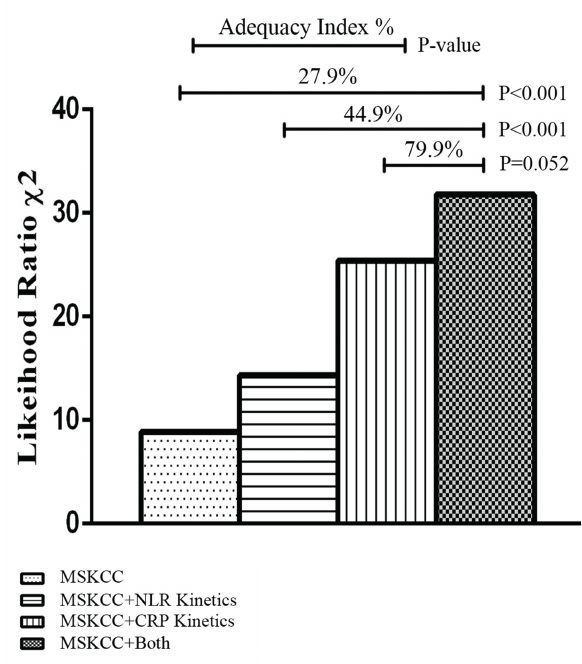
Figure 2 - The likelihood ratio χ ² test showing the adequacy index for different prognostic models. The columns, from left to right, show the adequacy indices for MSKcc, MSKcc+cRP kinetics, MSKcc+NLR kinetics, and MSKcc+cRP kinetics+cRP